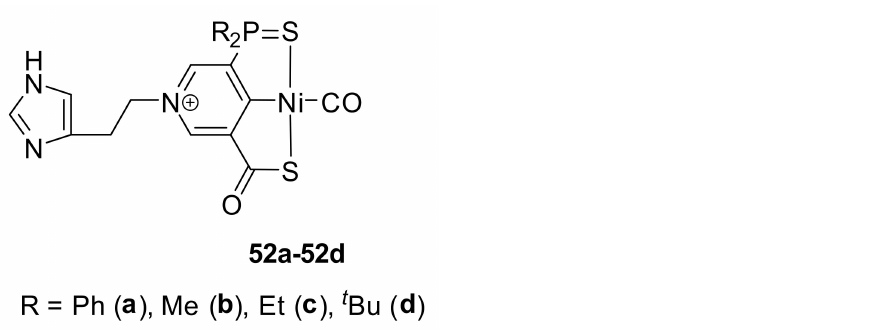
Figure 9. Structure of phosphorus-based SCS unsymmetrical pincer nickel complexes 52a – 52d [148]. It is also interesting to mention the phosphinite PONNOP expanded pincer ligand, which undergoes an unexpected rearrangement in the presence of nickel (II) species to form an unusual PONNP complex 53 (Scheme 29) [149]. Interestingly, the reaction of the PONNOP ligand with copper chloride did not lead to the rearrangement but to a binuclear PONNOP copper complex. The performed DFT calculations confirmed that PONNOP and PONNP free ligand isomers are similar in energy and have a high barrier for their interconversion. However, authors concluded that the P atom, which migrates from O to N, is bound to the transition metal atom, which provides the additional stabilization of the transition state to enable the isomerization toward the more stable PONNP pincer